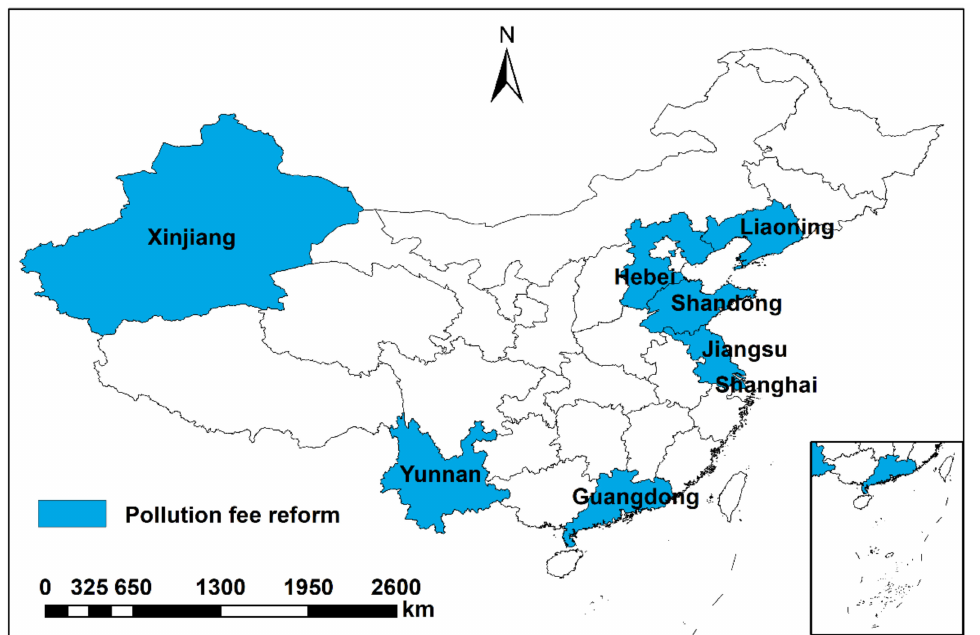
Figure 3. Spatial distribution of the pollution fee reform areas in China during 2006–2013.